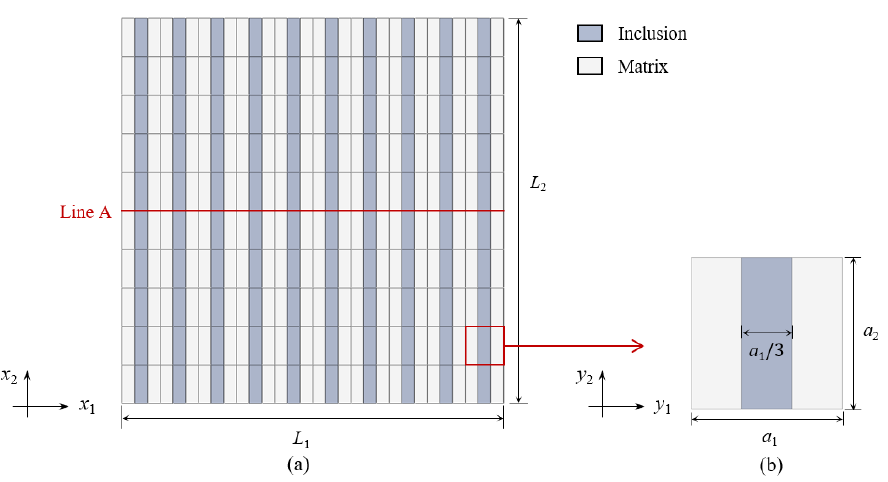
Figure 4. 2D periodic layered plate and its unit cell. ( a ) 2D periodic layered plate. ( b ) 2D unit cell.